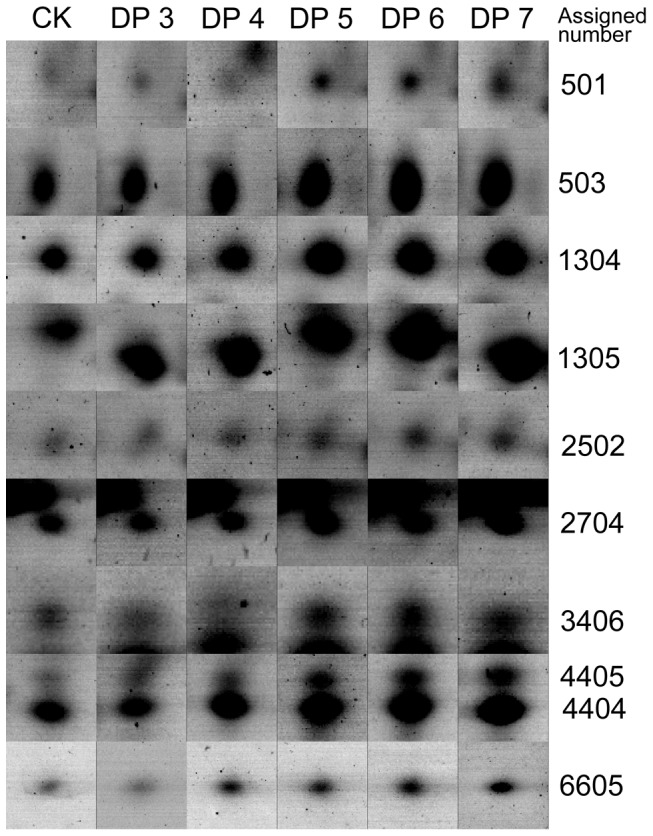
Comparison of protein spots from the elicitor-treated sets with the elicitor-free control.Proteins were extracted from the leaf cells at 12-free sample (blank control). DP, degree of polymerization.